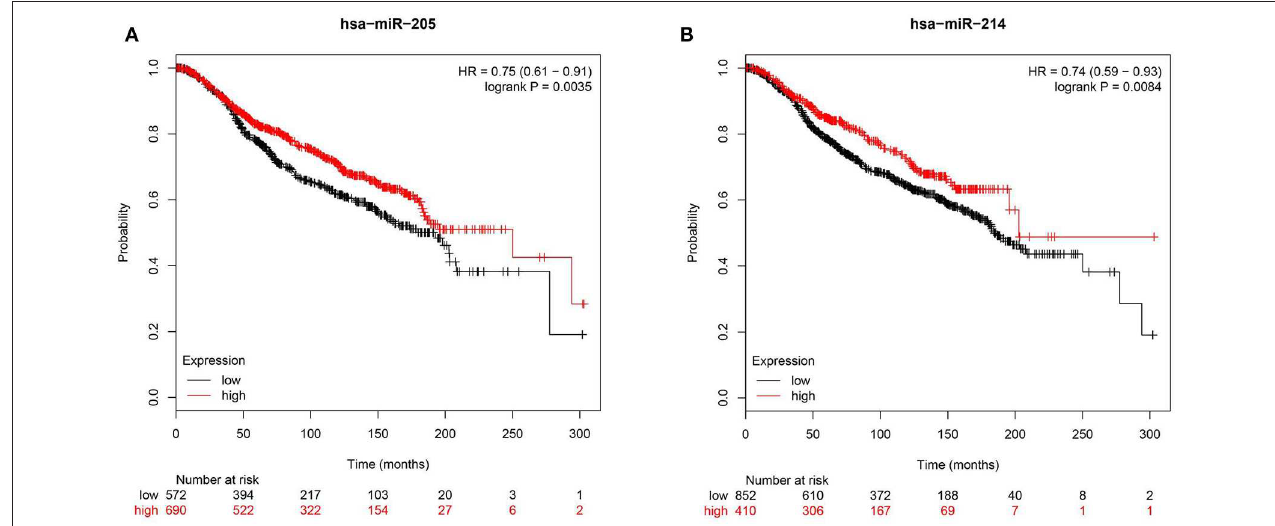
FIGURE 7 | Reduced expression of hsa-miR-205-3p or hsa-214-3p is associated with poor prognosis in BC patients. Kaplan-Meier curves illustrating the duration of overall survival (OS) of 1,262 BC patients stratified into high vs. low based on hsa-miR-205 (HR = 0.75, p = 0.003, A ) or hsa-miR-214 (HR = 0.74, p = 0. 008, B ) expression from the METABRIC BC